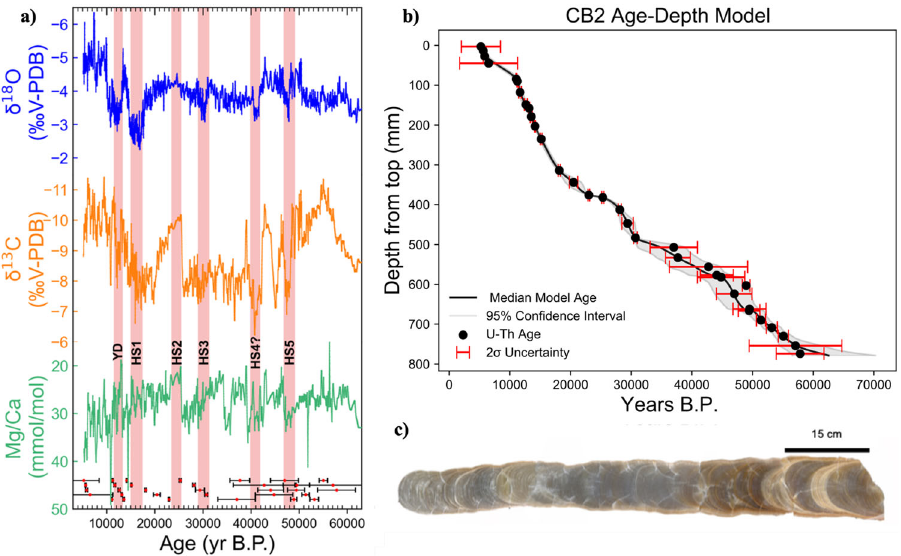
Fig. 2 | Stalagmite CB2, age-depth model and Mg/Ca, δ 18 O and δ 13 C results. a Results of 1578 stable isotope and 789 trace element measurements. δ 18 O is top and blue, δ 13 C is central and in orange, Mg/Ca is in bottom and green. Dates with associateduncertaintiesarebelowMg/Ca.HeinrichStadialshighlightedinlightred.